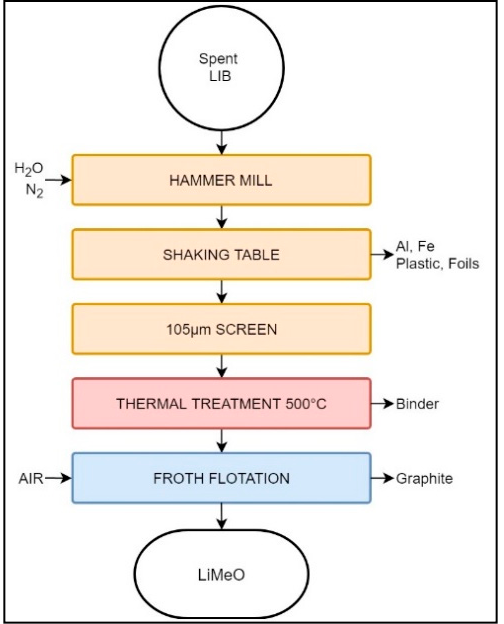
Figure 3. Schematic representation of the Retriev LIB recycling process for cathode-grade material Figure 3. regeneration.